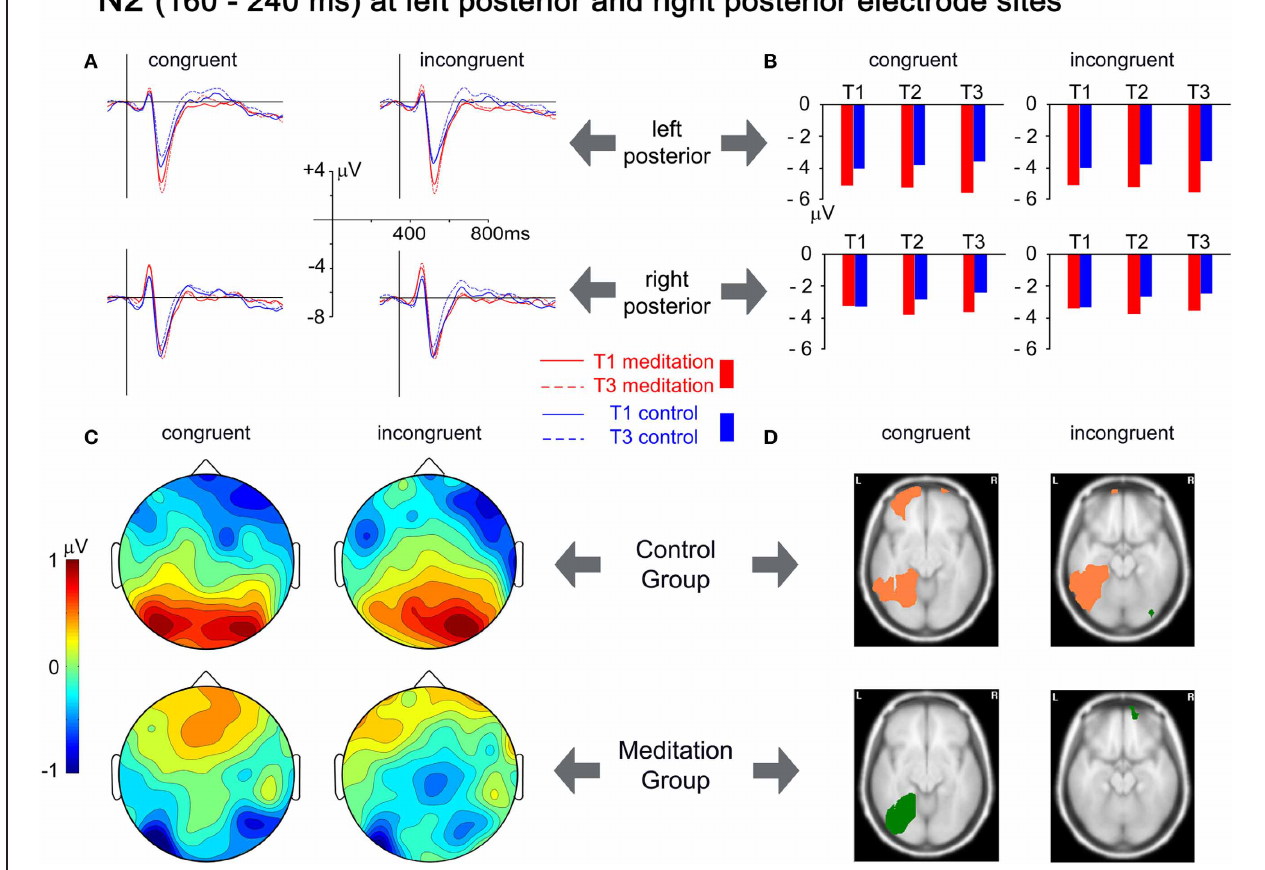
FIGURE 4 | Analysis of the N2 time window, from 160 to 240ms. (A) Grand mean averages for meditation and control group for T1 and T3 averaged over left posterior electrodes (PO7, PO3, O1; upper row) and right posterior electrodes (PO8, PO4, O2; lower row). (B) Mean N2 amplitudes from T1 to T3 averaged over the same electrode clusters. (C) Spherical spline interpolated scalp topographies of the difference between T1 and T3 (T3–T1) for meditation and control group, separated for congruent and incongruent stimuli. Positive values indicate a decrease